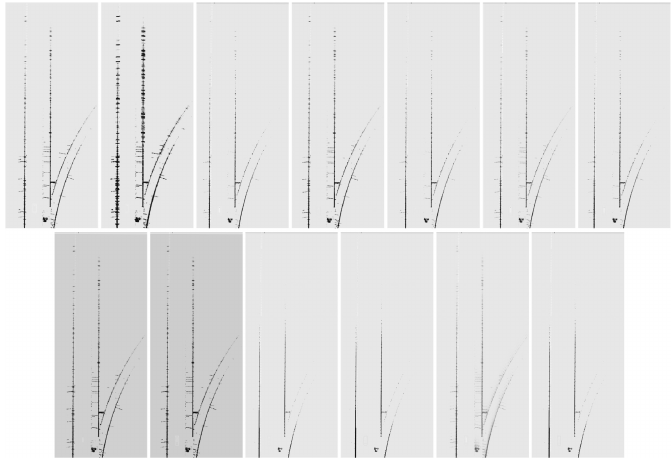
Figure 12. Snapshots of resultant occupancy grid for fusion variants in the first row: LL-B, LL-DS, HL-B, HL-M, HL-LI, HL-L, HL-I; in the second row: HL-De, HL-S, FHL-B, FHL-LI, FHL-L, FHL-I for Scenario 1).